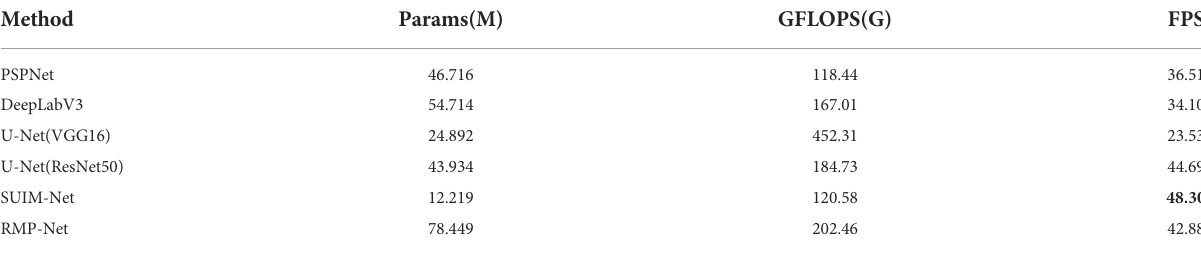
TABLE 9 Results of comparison of Params, FLOPS, and inference speed of different models (Single Nvidia RTX2080 GPU). Method